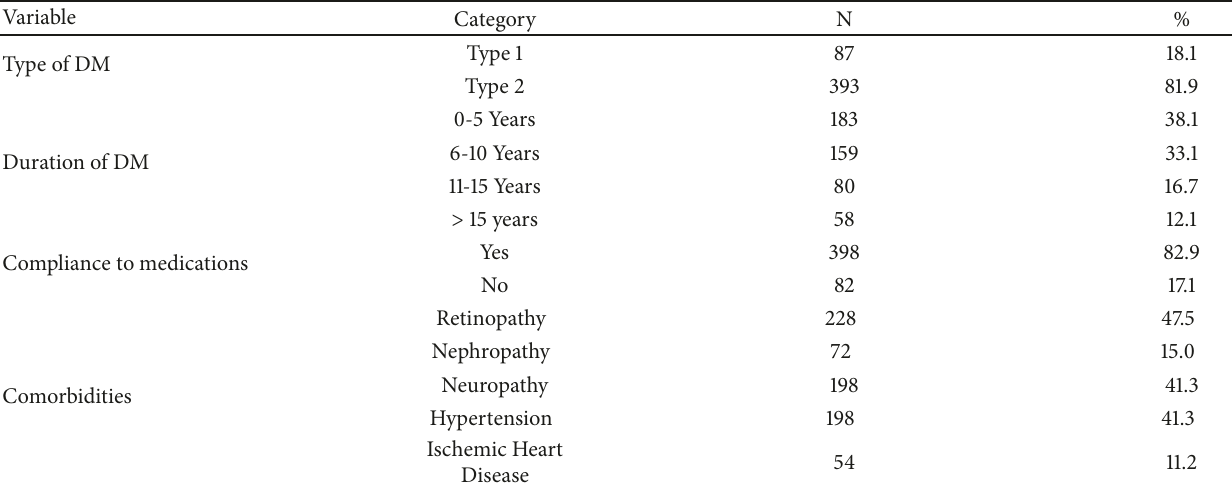
Table 2: Disease information of diabetic patients, Jazan, May 2017 (N = 480).